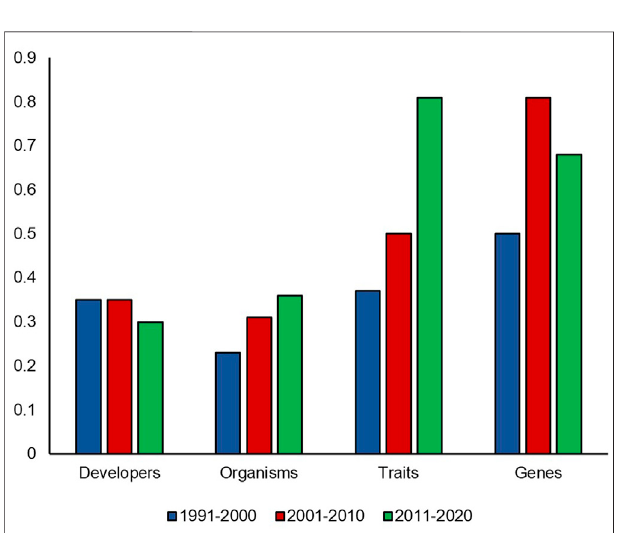
FIGURE 3 | Diversity ratios from 2011 to 2020. The number of submissions accounted for in this timeframe include all of the AIR submissions, but only the last 10 years of PDNS submissions. This timeframe re fl ects the years where the AIR & PDNS processes existed simultaneously. Redacted submissions in AIR are omitted from the ratio calculation.